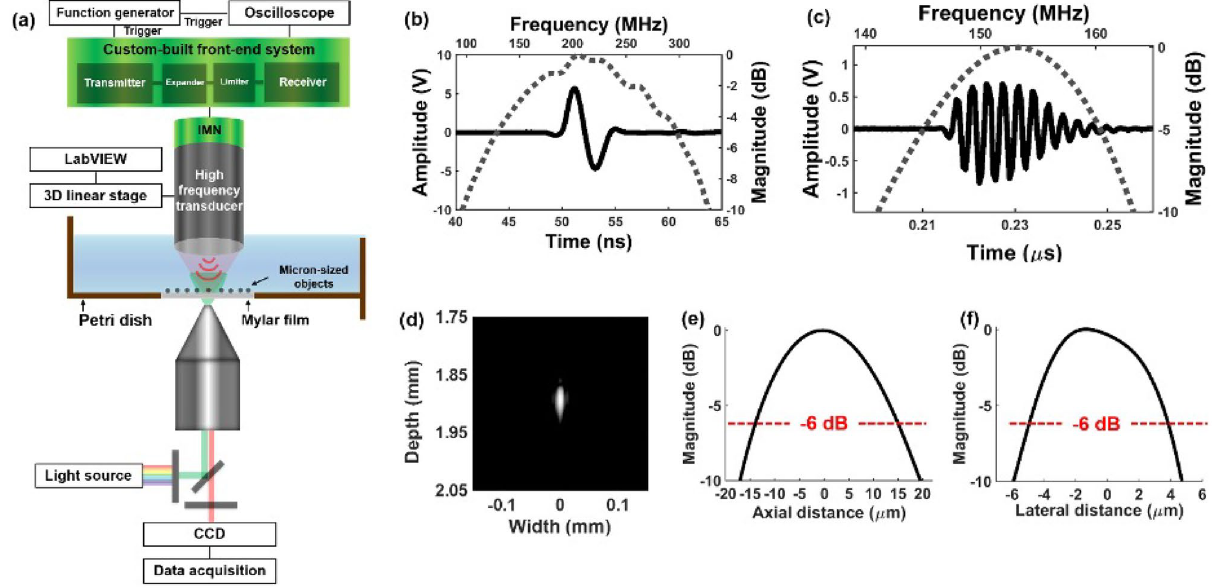
Figure 1. Label-free single-cell separation and analysis system. ( a ) Experimental setup consisting of a high- frequency ultrasound transducer with impedance matching network, custom-built front-end system, a three- dimensional linear stage, and oscilloscope, and an inverted fluorescence microscope with an image acquisition and analysis tool. ( b ) Measured pulse waveform and its spectrum of the custom-built front-end system. ( c ) Measured pulse-echo waveform and its spectrum of high-frequency ultrasound transducer with impedance matching network. ( d – f ) Measured spatial ultrasound pressures of the high-frequency ultrasound transducer with impedance matching